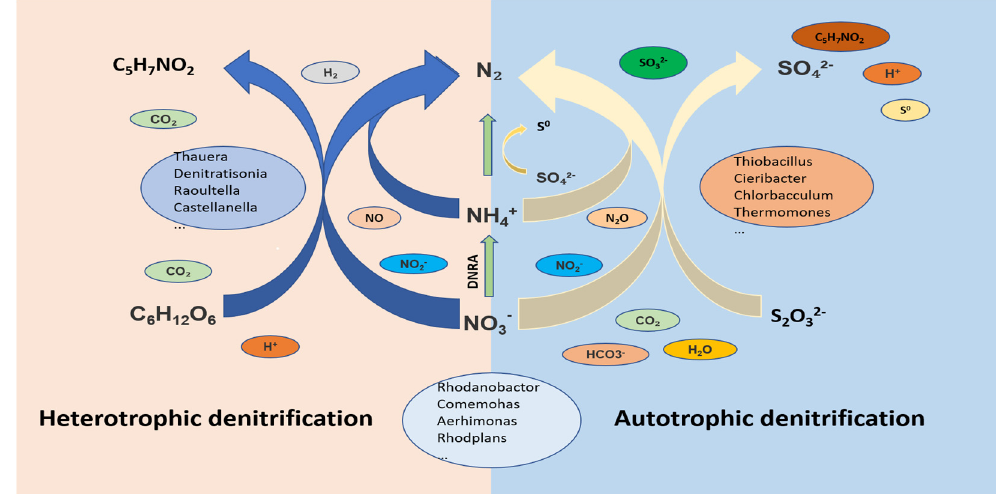
Figure 6. Mechanism of nitrogen and sulfur transformation, and removal pathway of the coupled denitrification.